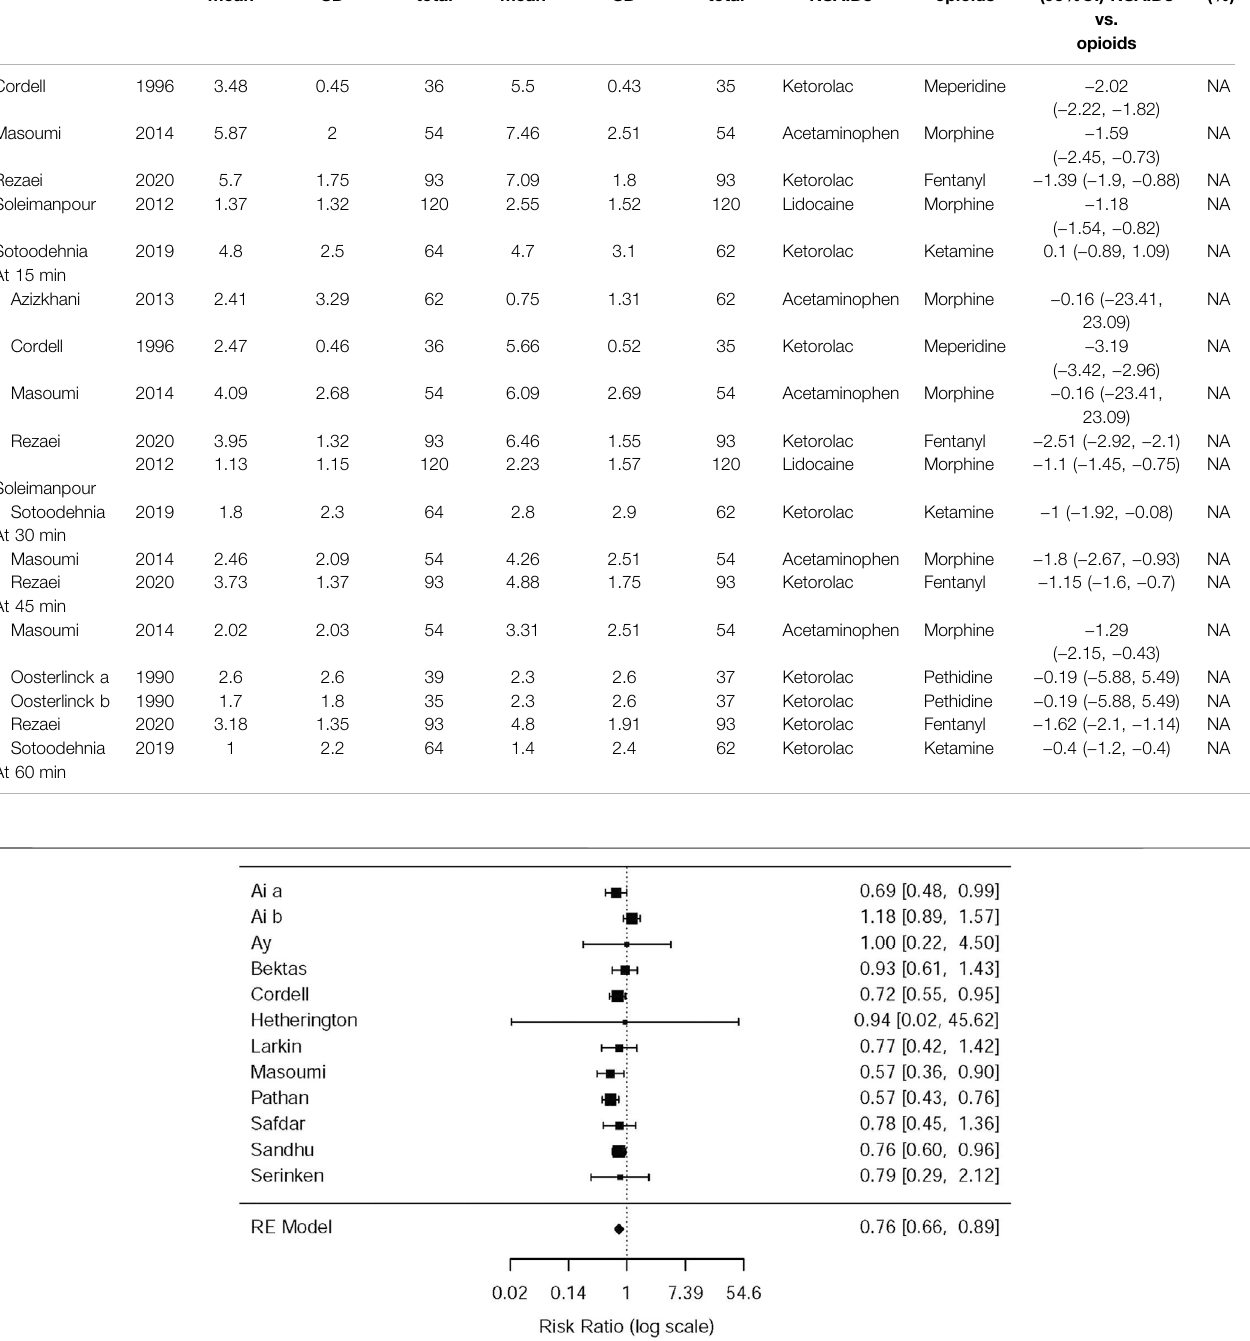
Frontiers in Pharmacology |